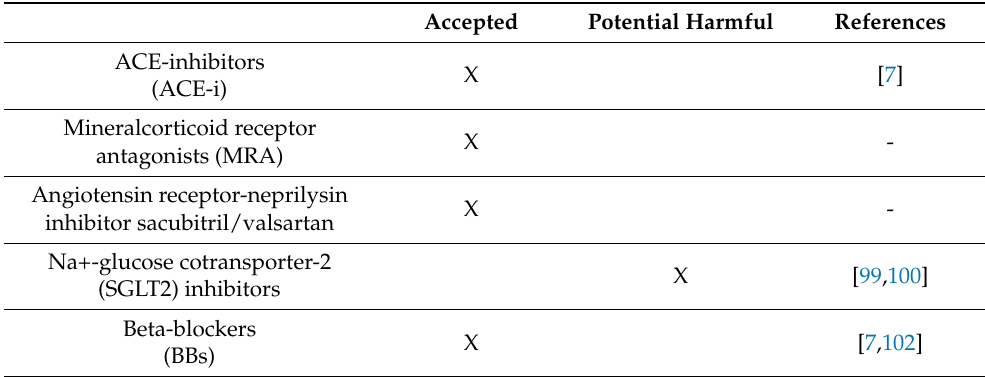
Table 1. Accepted medications for cardiac complications in propionic acidemia and medications considered potentially dangerous.